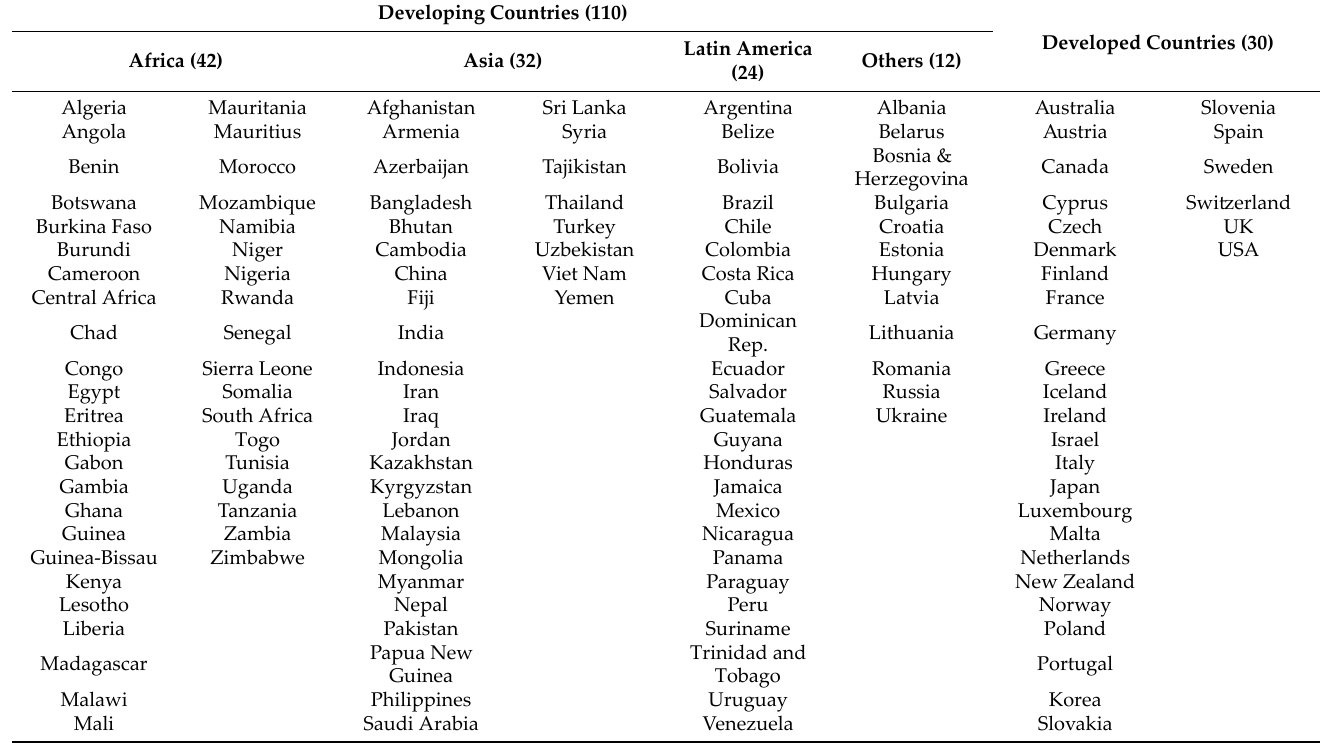
Table A1. Countries included in the empirical analysis.